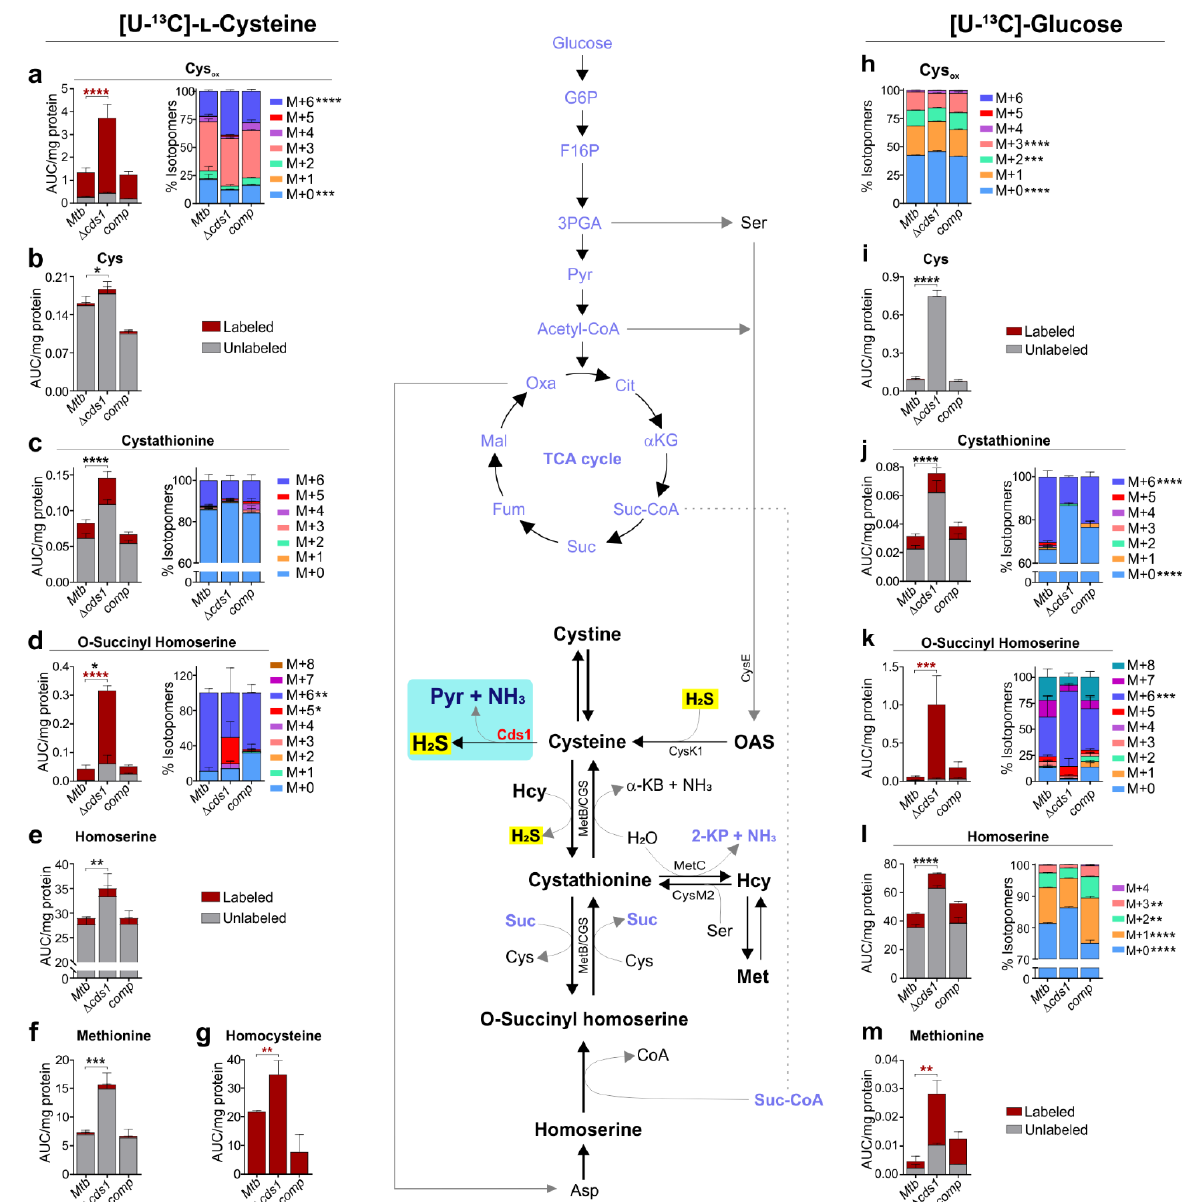
Figure 6. Cds1 regulates sulfur metabolism in Mtb . Schematic (center) showing metabolites in the transsulfuration pathway (black) linked with the glycolysis and TCA cycle (blue). LC-MS/MS analysis of metabolites in Mtb strains cultured in 7H9 medium with [U- 13 C]-Cys (100 µ M) ( a – g ) or [U- 13 C]-glucose (0.2%) ( h – m ). Representative experiments are shown; each experiment was repeated at least twice. Data represent the mean ± SEM for n = 3–5 biological replicates. Statistical analysis was performed using GraphPad Prism 8.4.3. Two-way ANOVA with Dunnett’s multiple comparisons test was used to determine statistical significance. * p < 0.05, ** p < 0.01, *** p < 0.001, and **** p <